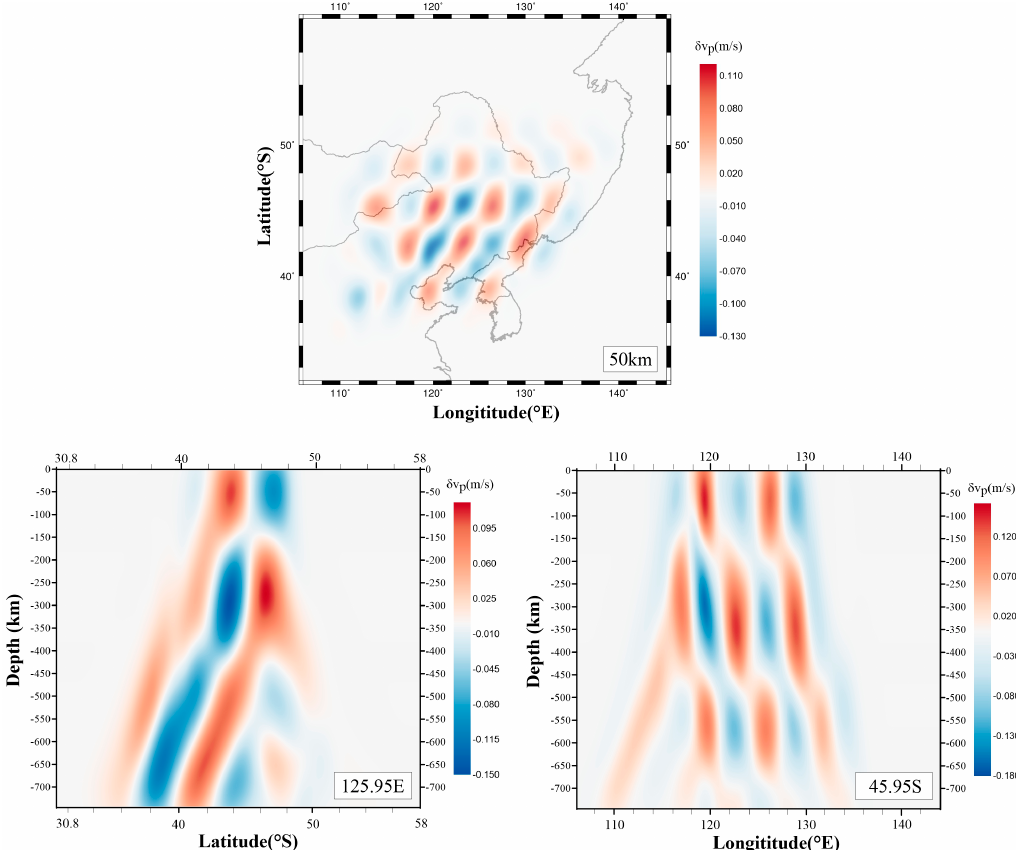
Figure 8. Test results and inversion results of 0.8° × 0.8° × 50 km grid